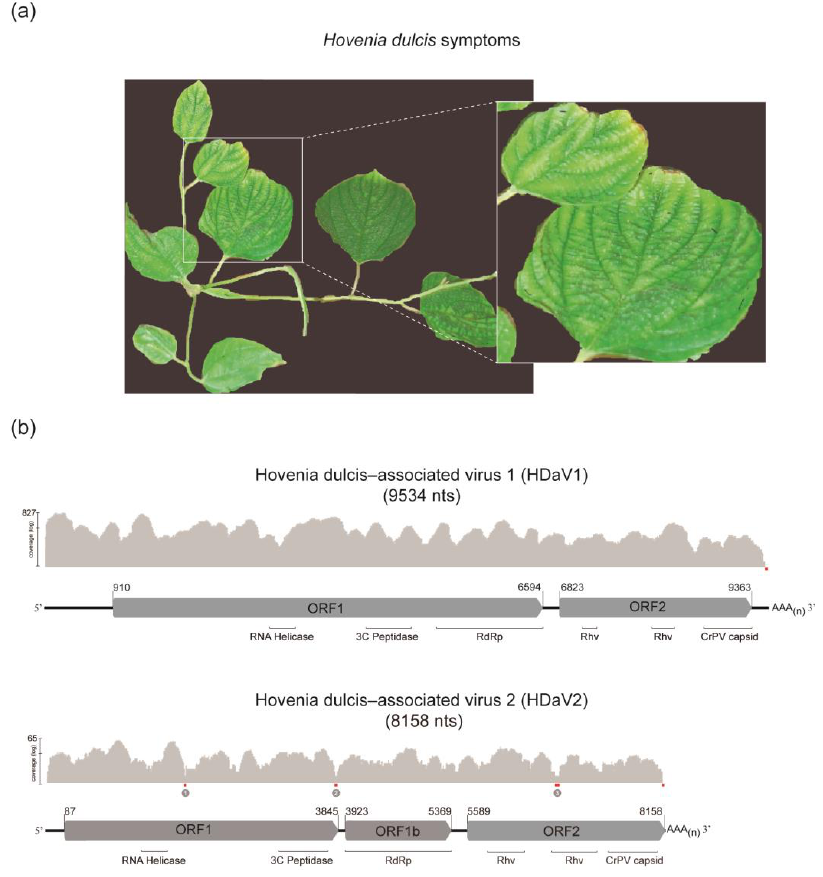
Figure 1. Hovenia dulcis symptoms and viral genomic organization. ( a ) Virus-like symptoms observed in leaves of Hovenia dulcis : interveinal chlorosis. ( b ) Schematic representation of Hovenia dulcis -associated virus 1 (HDaV1) and Hovenia dulcis -associated virus 2 (HDaV2) genomic organization and sequencing coverage. All open reading frames (ORFs) are represented as arrows pointing from the 5′ to the 3′ end and are colored in grey. Nucleotide positions indicate the start and end of ORFs. ORF 1 and 1b encodes non-structural polyproteins, including putative functional domains (RNA Helicase; 3C peptidase protease; and RdRp: RNA-dependent RNA polymerase). ORF 2 encodes a structural polyprotein with capsid protein domains (Rhv: picornavirus (Rhinovirus) capsid protein-like, CrPV capsid: cricket paralysis virus capsid protein-like). Regions with low coverage are highlighted in red, and the numbered regions were confirmed by RT-PCR and Sanger